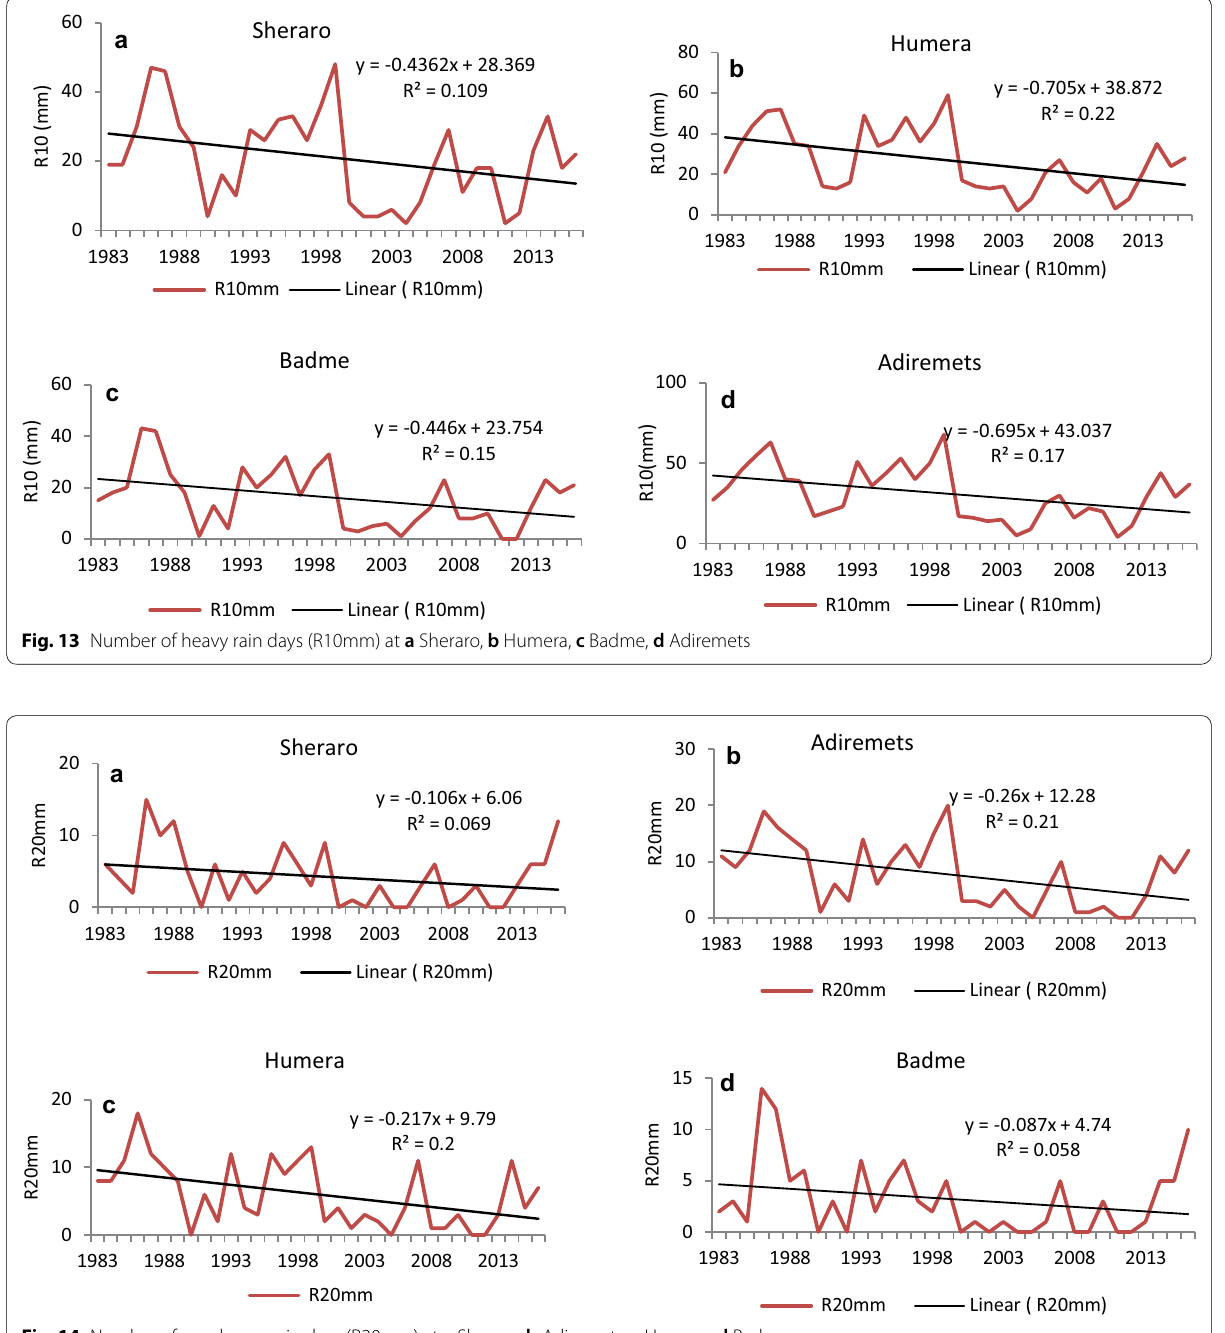
Fig. 14 Number of very heavy rain days (R20mm) at a Sheraro, b Adiremets, c Humera, d